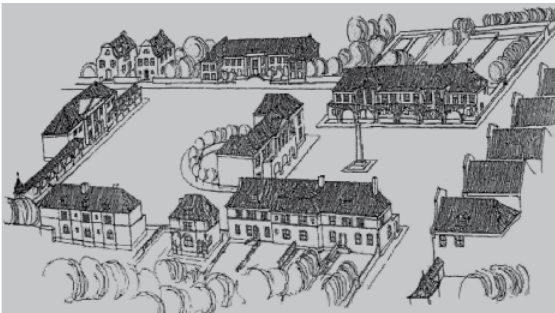
Fig. 7. bird’s view of market square in karłowice, architectu- ral competition in 1913